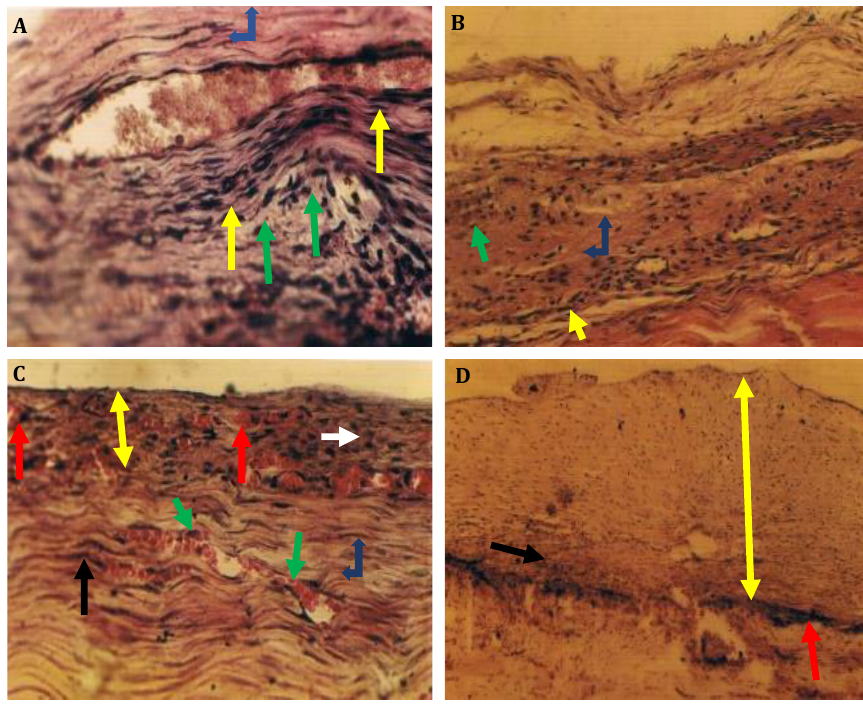
Figure 5. Representative sections of injured semimembranosus muscle tendon of local rabbit on 15th postoperative day in (A) Group A, irradiated with diode impulse laser at 1800 rad for 15 min showing severe infiltration of fibroblasts, presence of fibrocytes with elongated nuclei (yellow arrows), mild inflammatory cells (green arrows), and coherent collagen fibers (regular) (blue left-up arrow), H&E, 40×; (B) Group B, irradiated with diode impulse laser at 3000 rad for 25 min showing presence of fibrocytes with elongated nuclei (yellow arrow), little inflammatory cells infiltration (green arrow), and coherent regular collagen fibers (blue left-up arrow), H&E, 20×; (C) Group D, irradiated with diode impulse laser at 4200 rad for 35 min showing hemorrhages (red arrows), thick epitenon (yellow double-arrow), severe infiltration of fibroblasts (black arrow), mild inflammatory cells infiltration (white arrow), blood vessels (green arrows), and regular collagen deposition (blue left-up arrow), H&E, 40×;; (D) Group E, showing very thick epitenon (yellow double-arrow), severe infiltration of inflammatory cells (black arrow) and fibroblasts (red arrow), H&E,